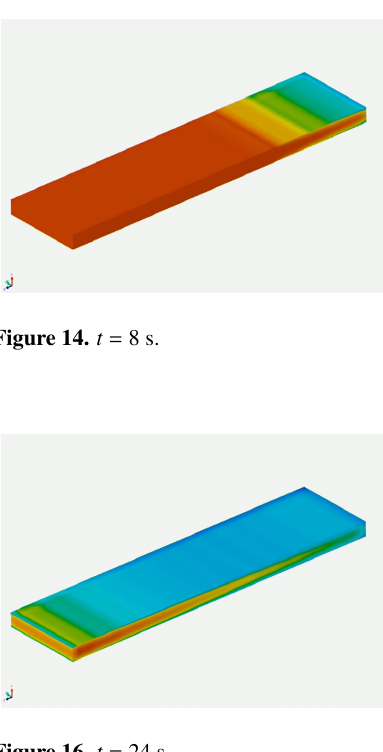
Figure 15. t = 16 s. Figure 16. t = 24 s.